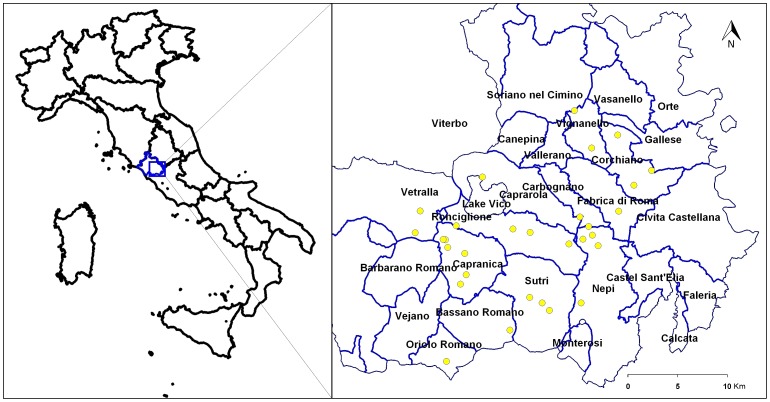
Feature map of the municipalities monitored for bacterial blight.The yellow balls within each municipality represent the number of investigated sites for each municipality, within the province of Viterbo, central Italy.